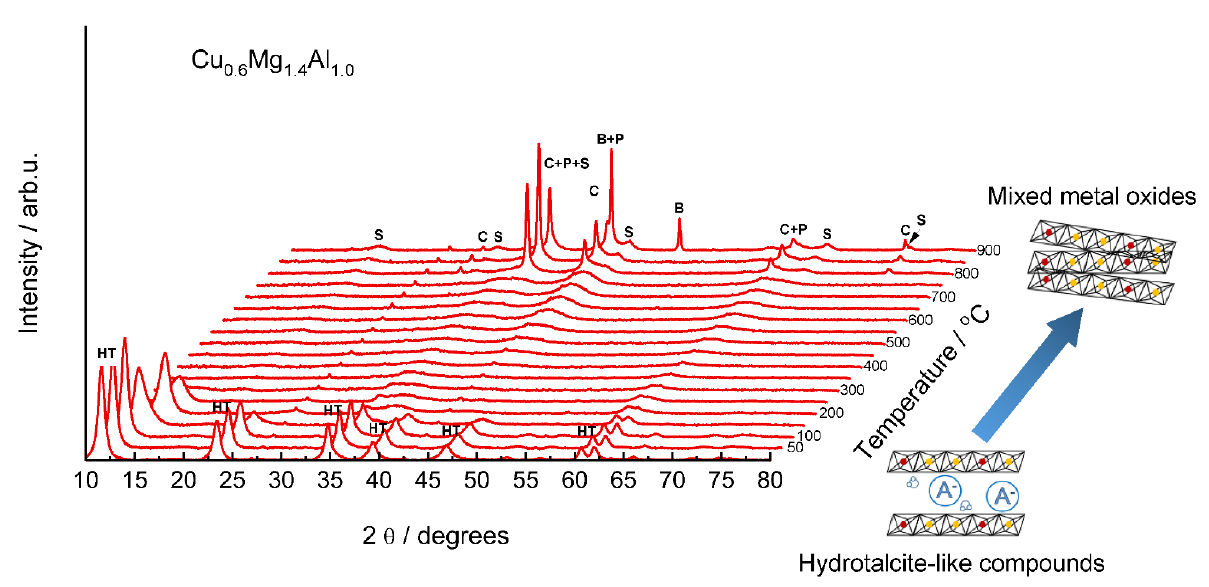
Figure 2. In situ XRD diffraction patterns of the Cu-Mg-Al hydrotalcite-like material recorded in oxidizing conditions. HT—hydrotalcite-like compounds, P—MgO (periclase), C—Cu 2 O (cuprite), S—MgAl 2 O 4 (magnesium aluminate) and/or CuAl 2 O 4 (copper aluminate), B—CuAlO 2 : Reprinted from [28] with permission from Springer. Table 1. Products obtained from the preparation of the CuM(II)M(III)CO 3 hydrotalcite-like com- pounds. Reprinted from [25] with permission from Elsevier.